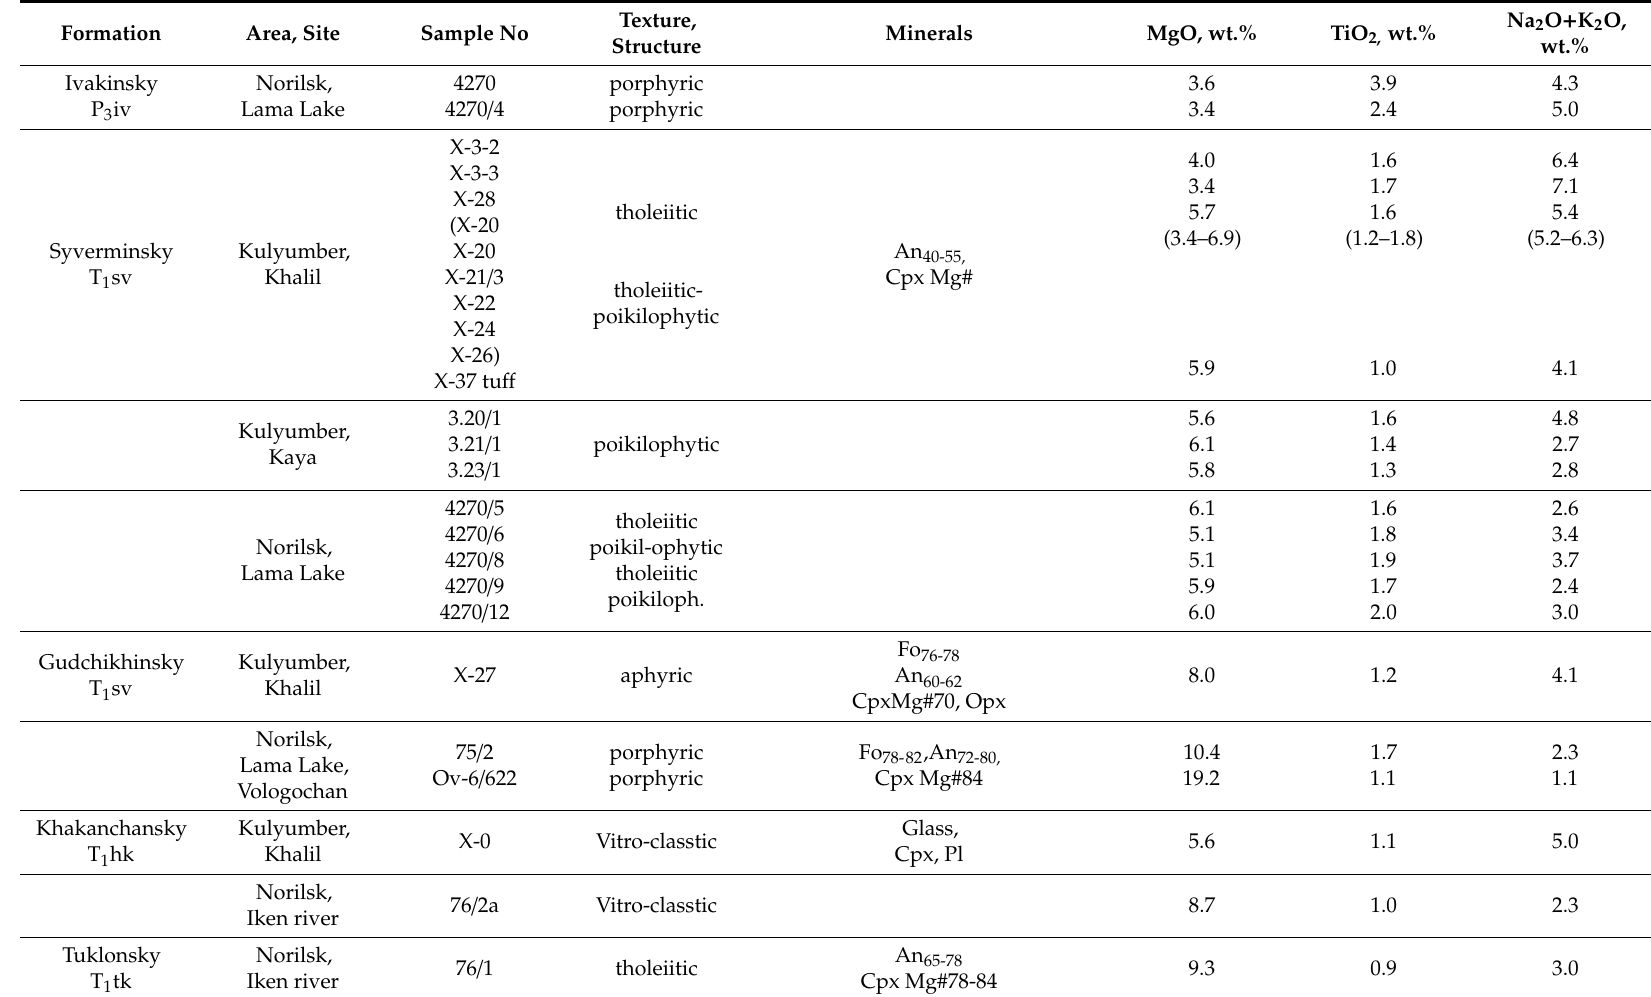
Table 6. Comparison of the mineralogical and geochemical features of the volcanic